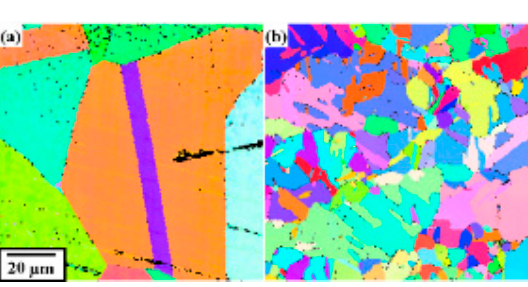
Figure 1. Schematic illustration of the specimen used for the ultrasonic bonding process. ( a ) The size of the bonding tool and copper terminal. ( b ) A clad material composed of copper/invar/copper used for the bonding substrate.